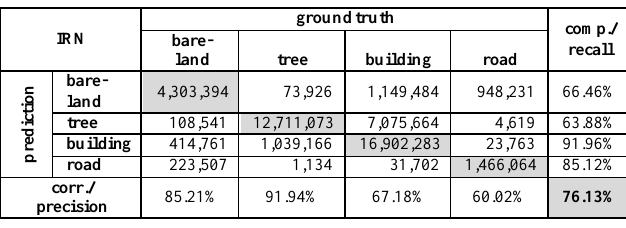
Table 3. Confusion matrix of segmentation result using IRN composition.